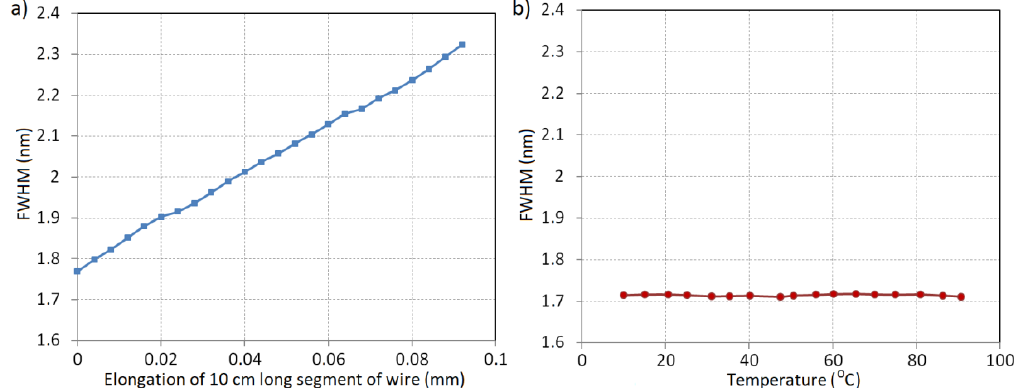
Figure 9. The characteristics of the FWHM spectral width dependency on ( a ) the relative elongation; and ( b ) the ambient temperature of the proposed system.